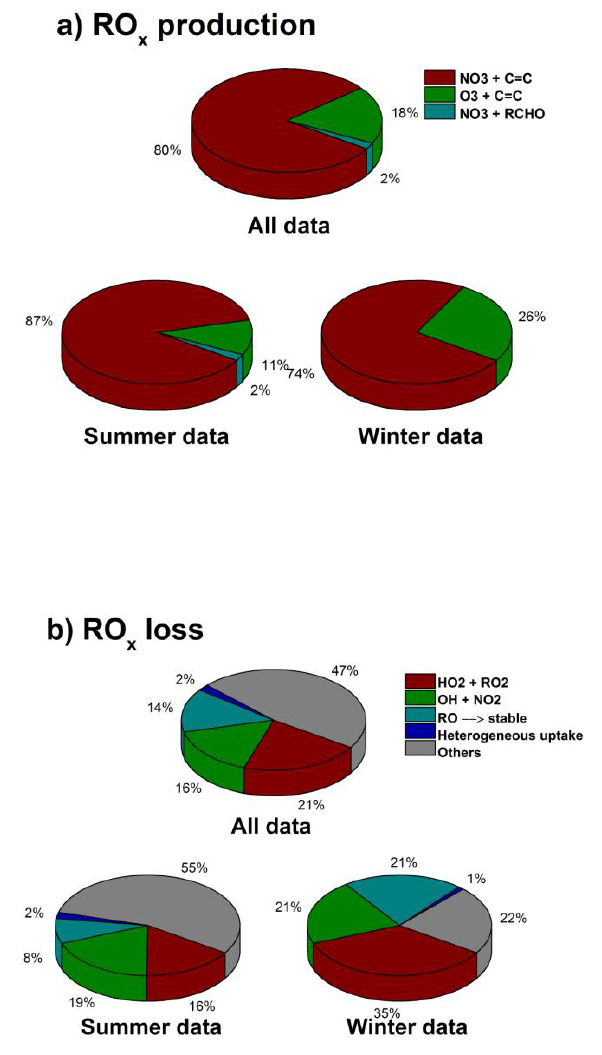
Fig. 7. Processes controlling the instantaneous production (a) and loss (b) of RO x ( = RO + RO 2 + OH + HO 2 ) radicals at night. The upper panels show the summer and winter campaign means combined, with the lower panels showing the summer campaign means (left hand side) and winter campaign means (right hand side). The average total production rate of RO x was (1.3 ± 1.1) × 10 5 cm − 3 s − 1 (median = 1.0 × 10 5 cm − 3 s − 1 ) for the entire data set, (1.6 ± 1.4) × 10 5 cm − 3 s − 1 (median = 1.2 × 10 5 cm 3 s -1 ) for the summer campaign and (1.0 ± 0.4) × 10 5 cm 3 s -1 (median = 0.9 × 10 5 cm 3 s -1 ) for the winter campaign. The average total loss rate of RO was (1.6 ± 1.2) × 10 5 cm 3 s -1 (median = 1.2 × 10 5 cm 3 s -1 ) for the entire data set, (1.9 ± 1.4) × 10 5 cm 3 s -1 (median = 1.6 × 10 5 cm 3 s -1 ) for the summer campaign and (1.0 ± 0.3) × 10 5 cm 3 s -1 (median = 0.9 × 10 5 cm 3 s -1 ) for the winter campaign.